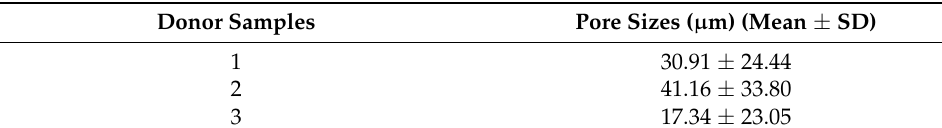
Figure 1. Platelet-rich fibrin (PRF) preparation. ( A ) Venous blood centrifuged for separation. PRF clot formed in the tube centre between red blood cells and platelet-poor plasma fractions. Appear-